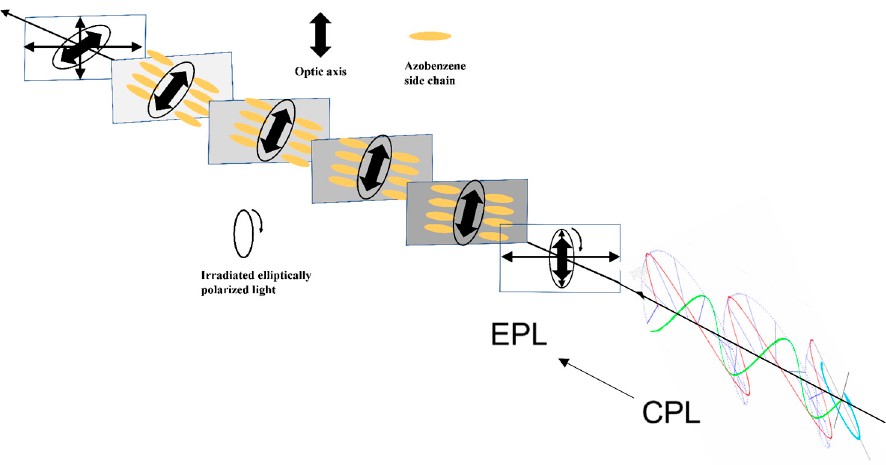
Figure 12. Sequence illustrating the formation of helical structure by CPL irradiation. (Reproduced from [206] with permission from The Royal Society of Chemistry).